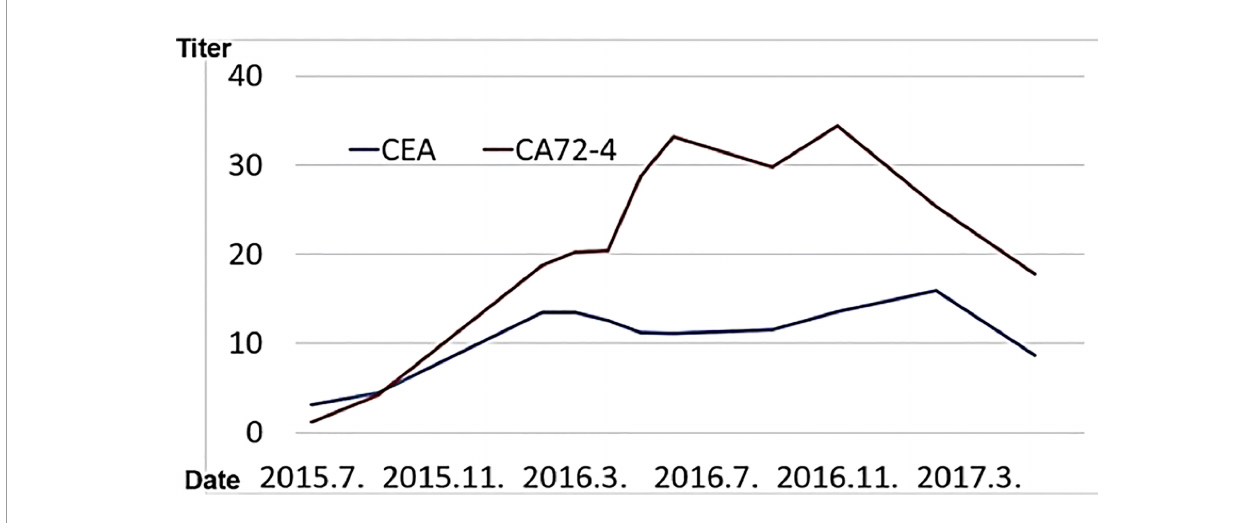
FIGURE 10 | His tumor marker (CEA, CA72-4) values are shown.